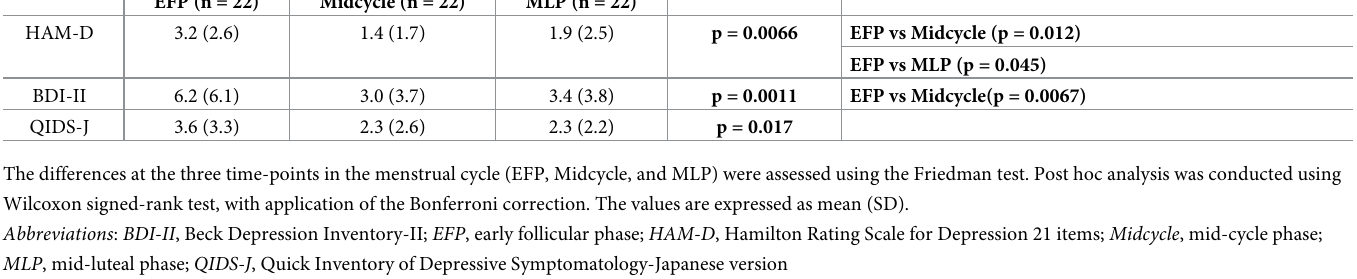
Women in the EFP had significantly higher mean scores on HAM-D than in men (p = 0.0197). Statistically significant differences in scores on HAM-D were not observed between men and women in the Midcycle (p = 0.1708) or between men and women in the MLP (p = 0.1381). The scores for each subitem of HAM-D, BDI-II, and QIDS-J are shown in S2 Table.